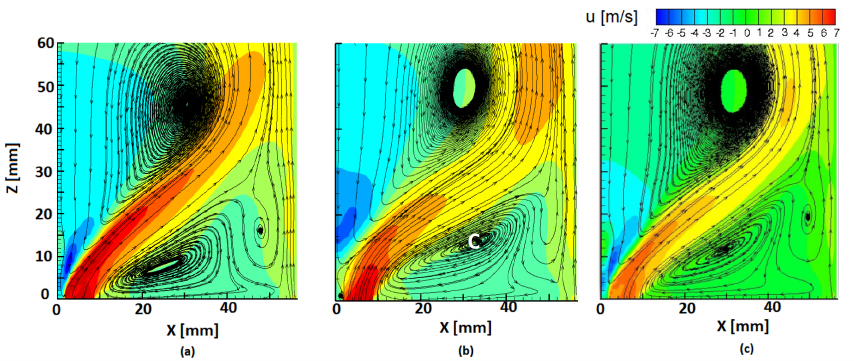
Figure 13. Flow comparisons-axial velocity profile shown for the combustion model ED and different turbulence models: ( a ) RNG k- (cid:101) , ( b ) k- ω and ( c ) SST.